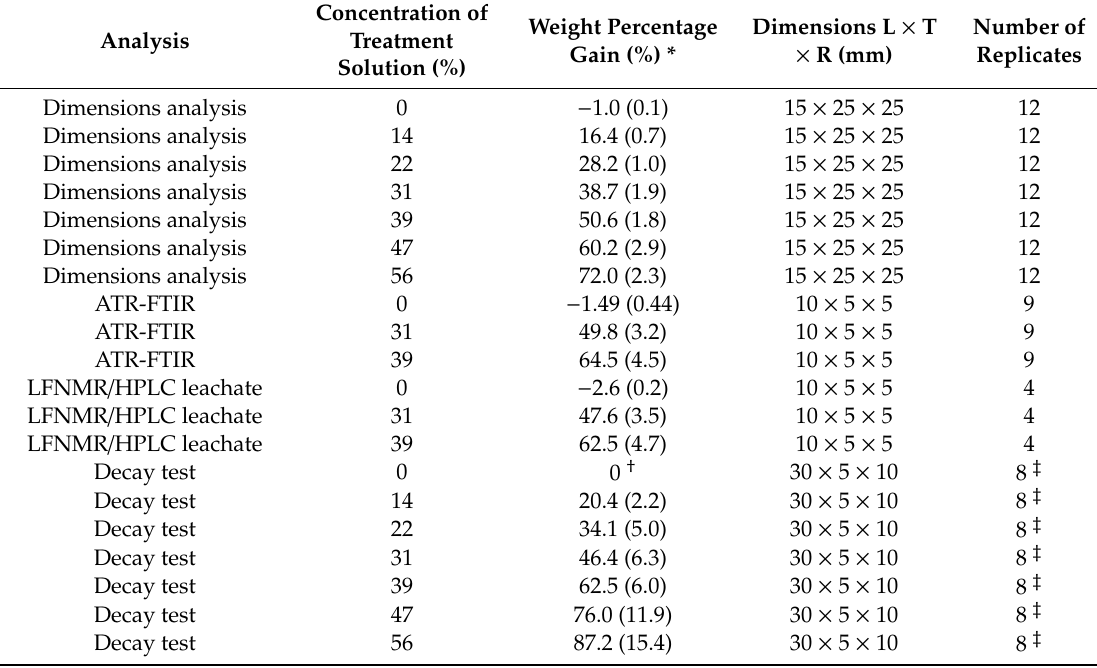
Table 1. Sorbitol citric acid treatment, weight percentage gain, sample dimensions and number of replicates used for the various analyses. Standard deviation in parentheses.